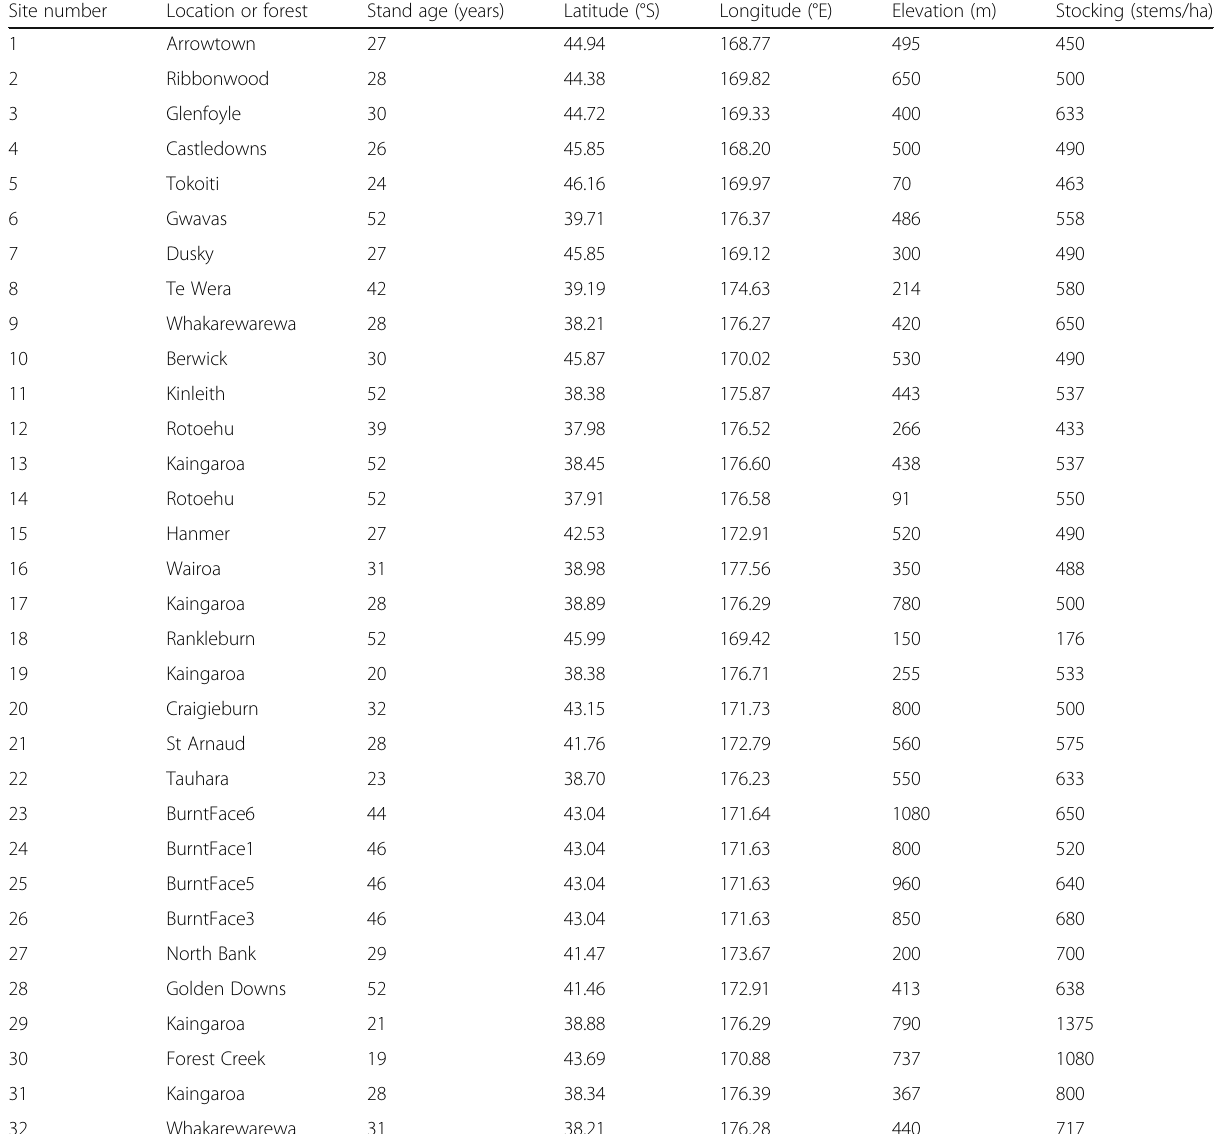
Table 1 Location and age of Douglas-fir stands sampled in a national wood density survey used to develop sub-model 1 Site